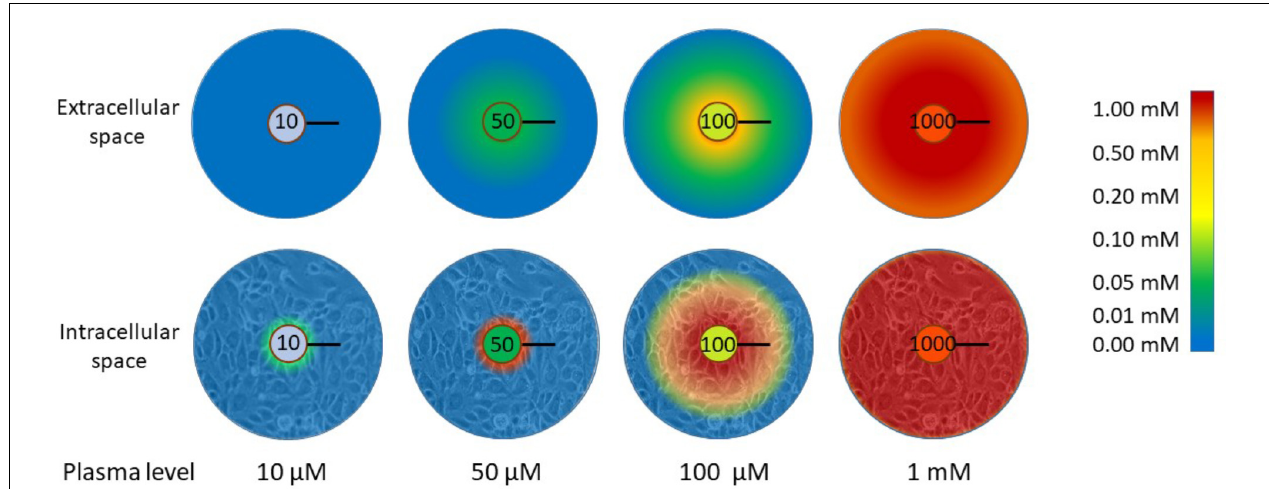
FIGURE 3 | The distribution of ascorbate through extracellular tissue and into tissue cells in relation to plasma concentration. When plasma levels are low (10 µ M), virtually no ascorbate is able to reach the tissues. This represents a state close to scurvy (complete deficiency). There is a significant difference in the capacity for ascorbate to accumulate in tissue cells when plasma levels are in the ‘healthy but not saturated’ range (50 µ M) or saturated (100 µ M). Below saturation, only cells adjacent to the blood vessel wall accumulate physiological intracellular concentrations (low mM). Diffusion of ascorbate does not extend beyond 100 µ m with plasma ascorbate ≤ 100 µ M and cells beyond this limited distance cannot accumulate ascorbate. To reach beyond this diffusion limit, supra-physiological levels are required. The diffusion distance for oxygen in tissues is 100 µ m and this is the average distance between blood vessels in well-perfused tissues (Ludke et al., 2009, 2010; Volta et al., 2013). The data represented in this figure are from Kuiper et al. (2014c). The black bars represent 100 µ m.